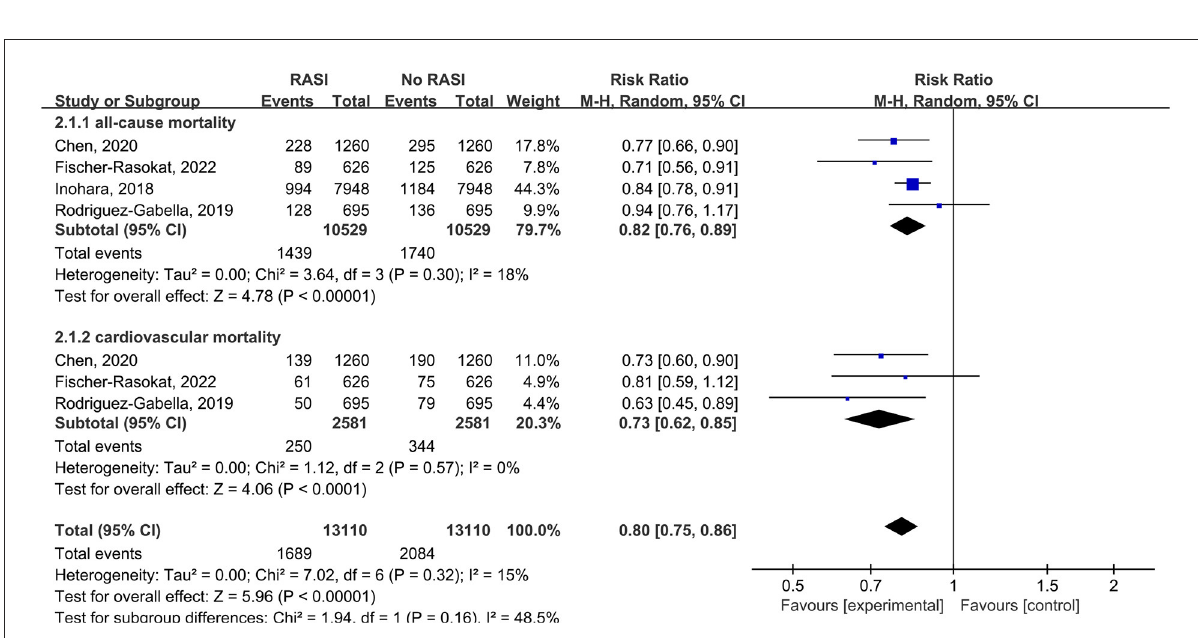
FIGURE4 Forest plots of random-effects meta-analysis for the rates of all-cause mortality and cardiovascular death after propensity matching.